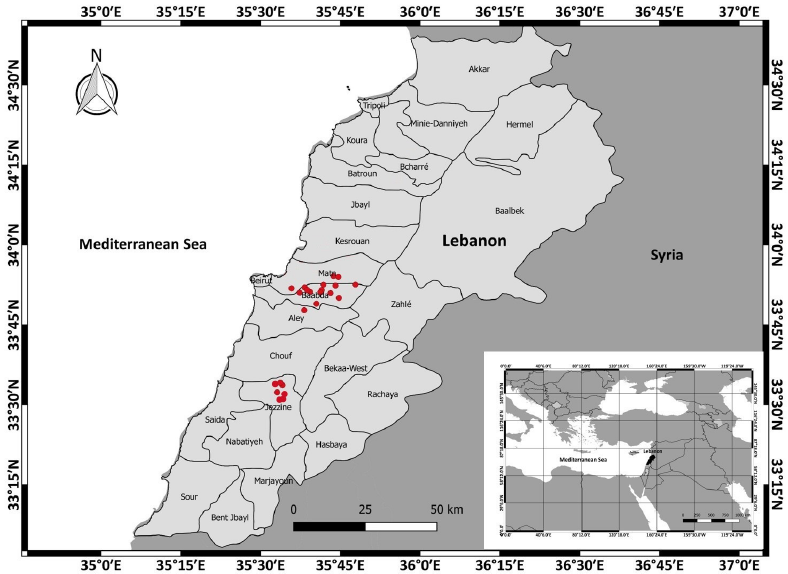
Figure 1. Map of the studied forest sites in